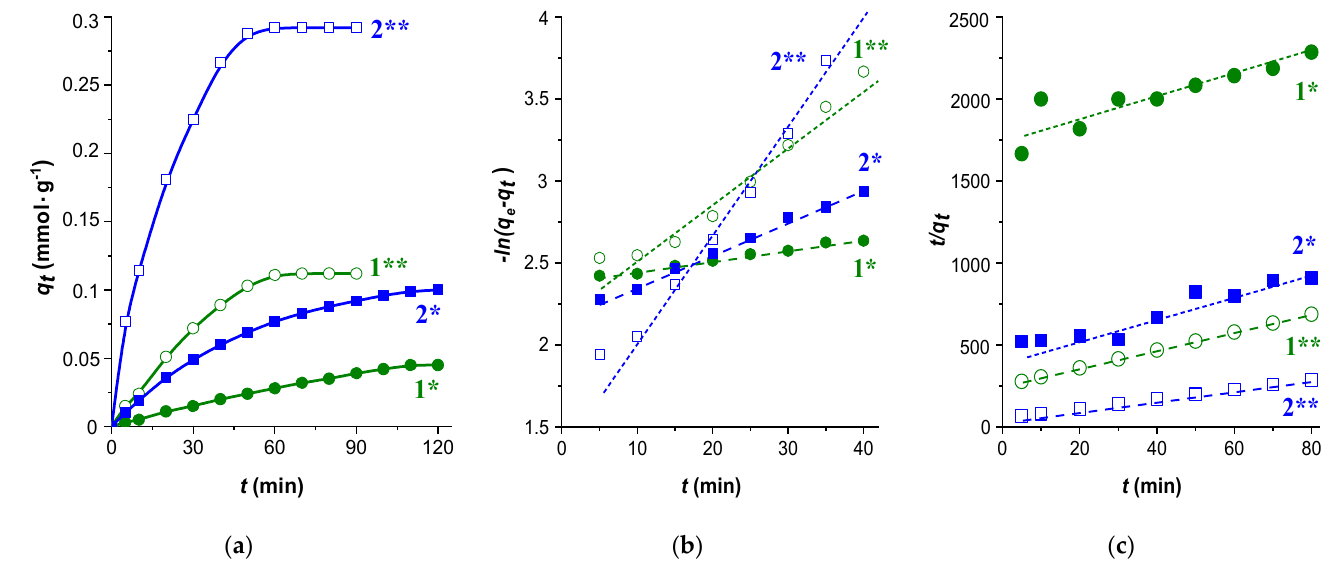
Figure 8. ( a ) Kinetics of theophylline adsorption by pectin samples; ( b ) pseudo-first-order model; ( c ) pseudo-second-order models: 1 * and 1 **— Р С t , рН 2.0 and 5.0; 2 * and 2 **— Р Rh , рН 2.0 and 5.0.